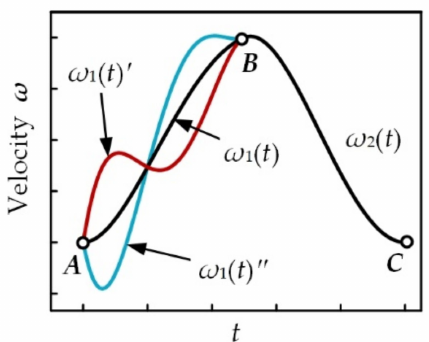
Figure 5. Angular velocity fluctuation in quintic polynomial